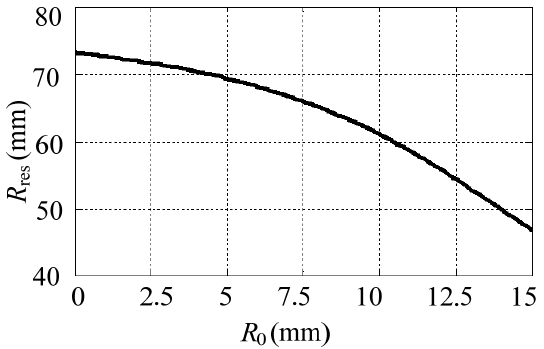
Figure 3. Variation of R res with r 0 .